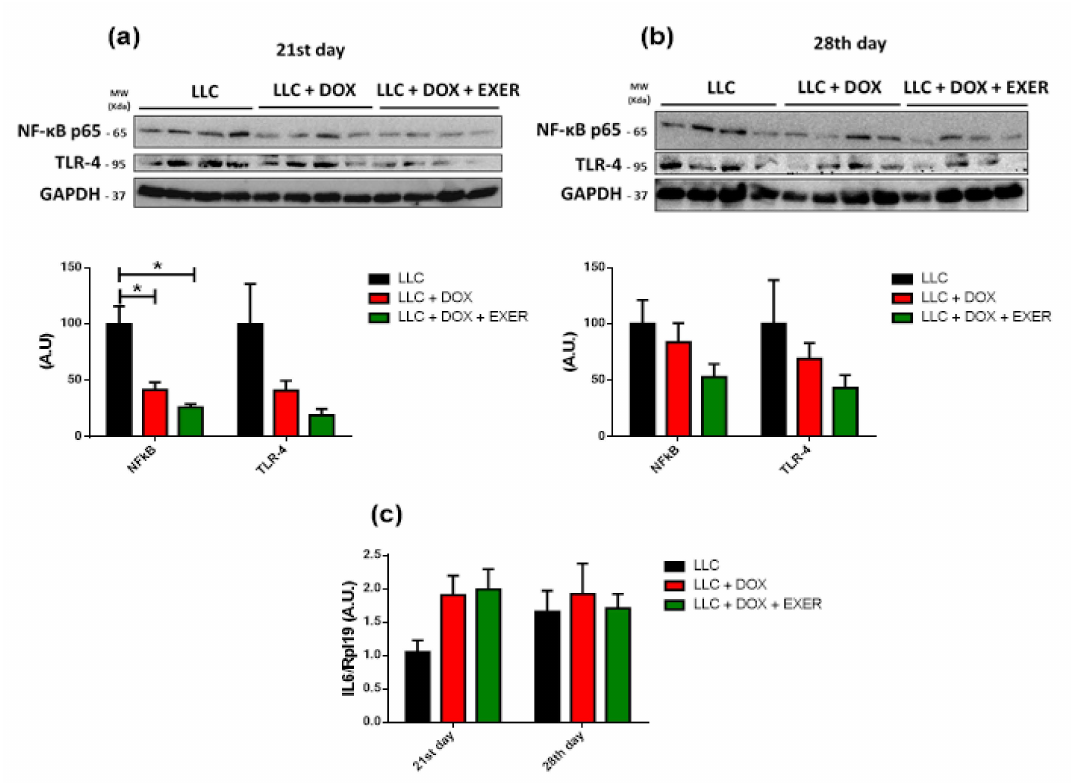
Figure 6. Inflammatory signaling in skeletal muscle. ( a ) Protein expression of TLR-4 and NF- κ B in the gastrocnemius muscle immediately after chemotherapy. n = 4. ( b ) Protein expression of TLR-4 and NF- κ B in the gastrocnemius muscle in the post-chemotherapy period. n = 4. ( c ) Gastrocnemius IL-6 gene expression. n = 5–6. Values represent the mean and standard error of the mean of the analysis of the data obtained. * p < 0.05. LLC = Lewis lung carcinoma; DOX = doxorubicin; EXER = endurance exercise. The uncropped Western Blots are available in Figure